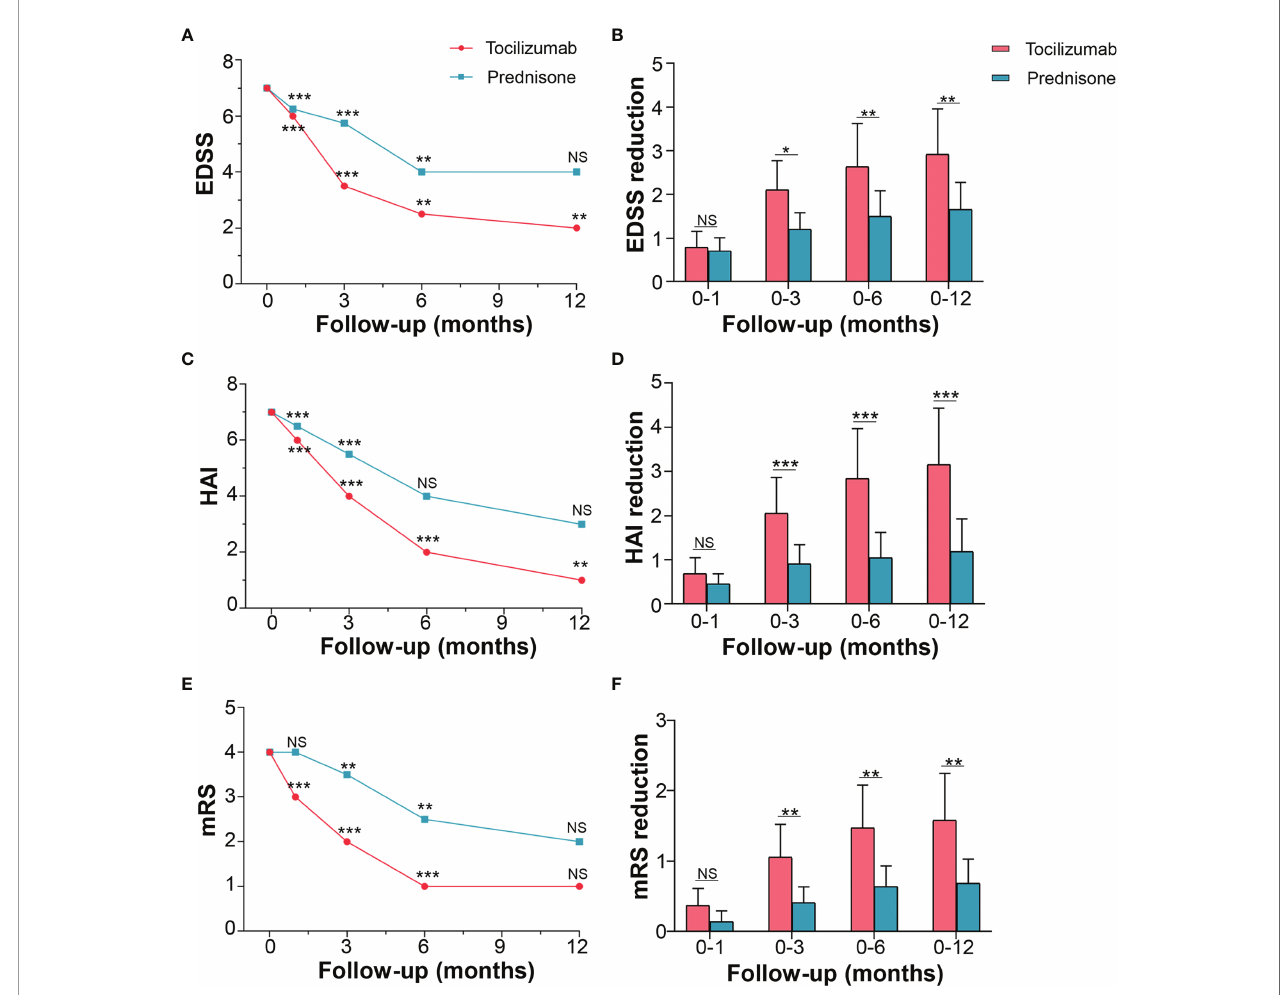
FIGURE 2 | Effects of tocilizumab and prednisone on motor function. (A) EDSS changes from the baseline to the one-year follow-up in the tocilizumab and prednisone groups. (B) Comparison of EDSS reduction rate between the wo groups. (C) HAI changes and (D) comparison between the two groups. (E) mRS changes and (F) comparison between the two groups. EDSS: expanded disability status scale; HAI: Hauser ambulation index; mRS: modi fi ed Rankin scale. * represents a signi fi cant decline in score between the current and previous follow-ups. * p < 0.05; ** p < 0.01; *** p < 0.001; NS, not signi fi